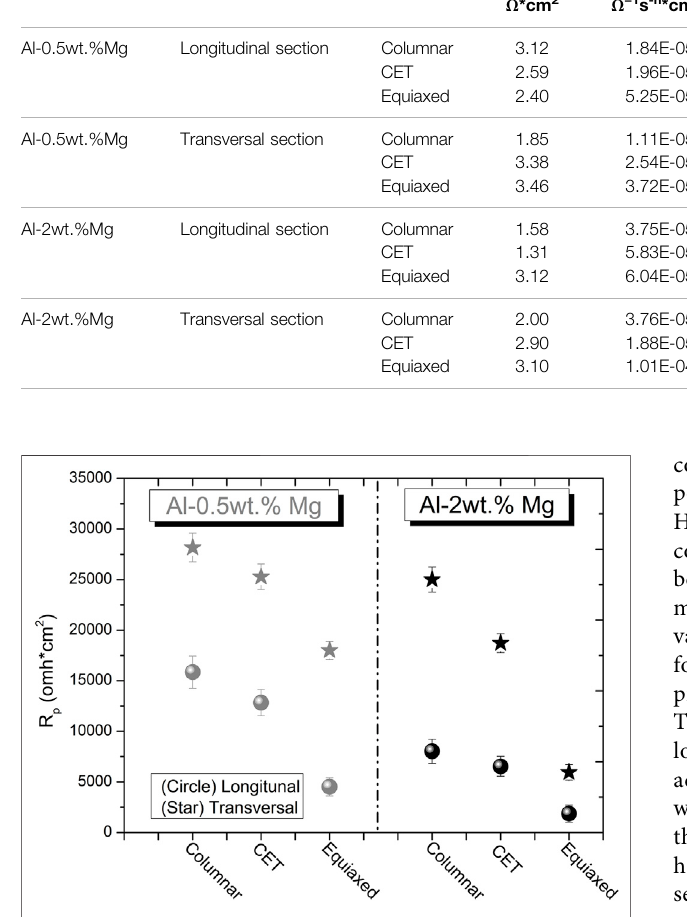
FIGURE 11 | Polarization resistance, Rp, of Al-Mg alloys in 0.5 M NaCl